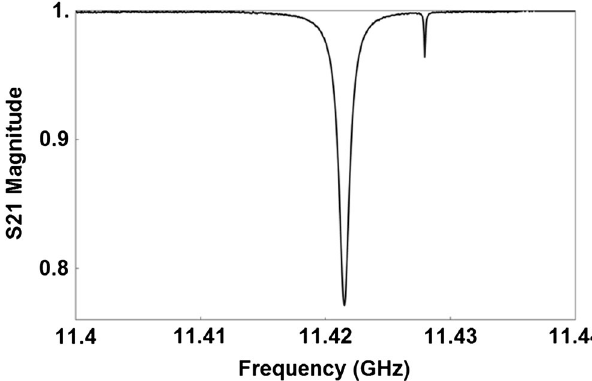
FIG. 12. Cold test results of configuration-C measured with an Agilent N5242A PNA-x showing the transmission properties S21 of the network.